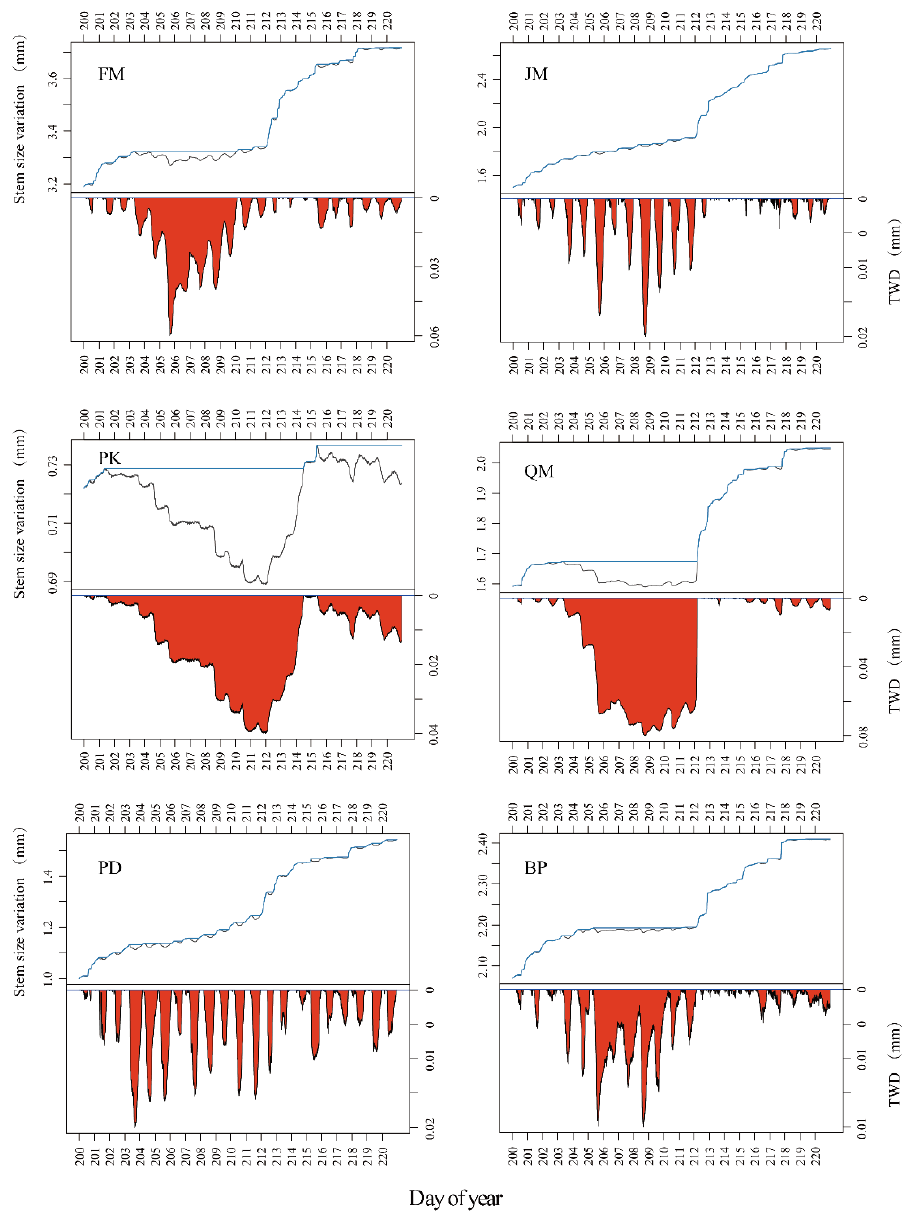
Figure 5. TWD changes in tree stem diameter of six tree species during DOY200-220. The data are available at 15-min intervals. The black line is the true value of tree stem diameter change, and the blue line is the ZG model of tree stem growth. FM: Fraxinus mandshurica ; JM: Juglans Mandshurica Maxim.; PK: Pinus koraiensis Sieb. et Zucc.; QM: Quercus mongolica Fisch.; PD: Populus davidiana Dode.; BP: Betula platyphylla Suk.